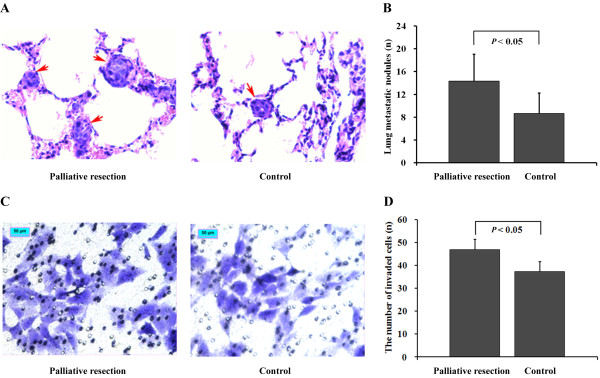
Difference in tumor invasion and metastasis. (A) The representative pulmonary metastatic nodules (arrows, original magnification, ×400). (B) The difference in lung metastasis (P < 0.05). (C) The penetrated cells (original magnification, ×200) treated by resection mice serum (left) was higher than that of control (right), bar, 50 μm. (D) The difference in invasiveness (P < 0.05). The bars indicate the means ± SD.